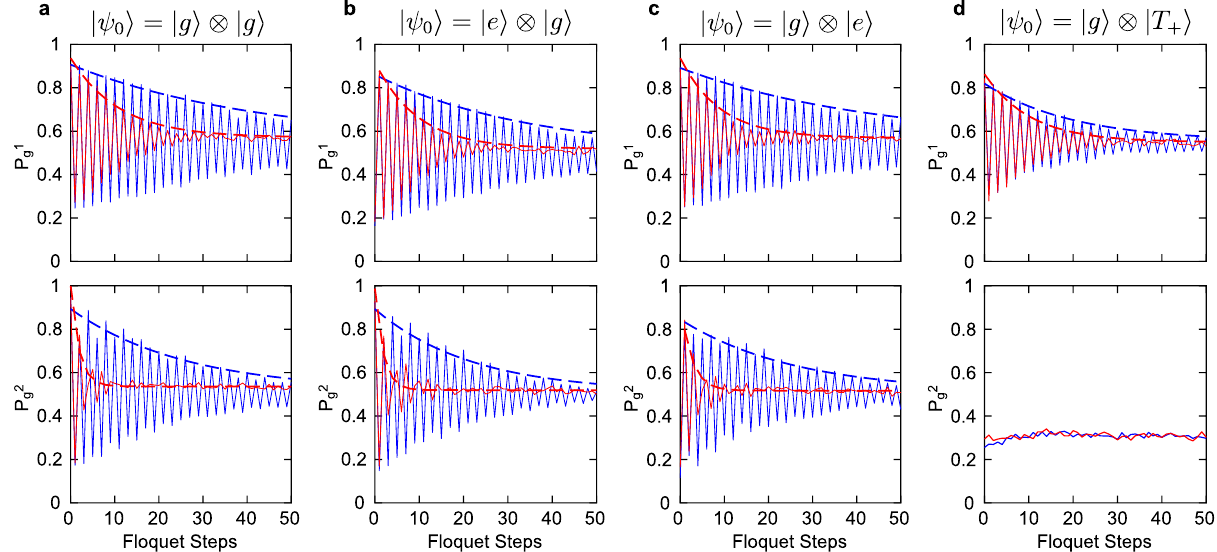
Fig. 4 Floquet-enhanced spin swaps. a – d Quality-factor enhancement of spin-eigenstate swaps for different initial states. In each fi gure, the top panel shows the measurements of ST qubit 1, and the bottom panel shows the measurements of ST qubit 2. The initial states are shown on the top, where g j i and e j i represent the ground state and the excited state of the ST qubit, respectively. The Floquet-enhanced π -pulse data are shown in blue, and the non- enhanced regular π -pulse data are shown in red. The fi tted exponential decay envelopes are overlaid as dashed lines for all data except for the bottom panel in ( d ). The data are averaged over 4096 realizations.